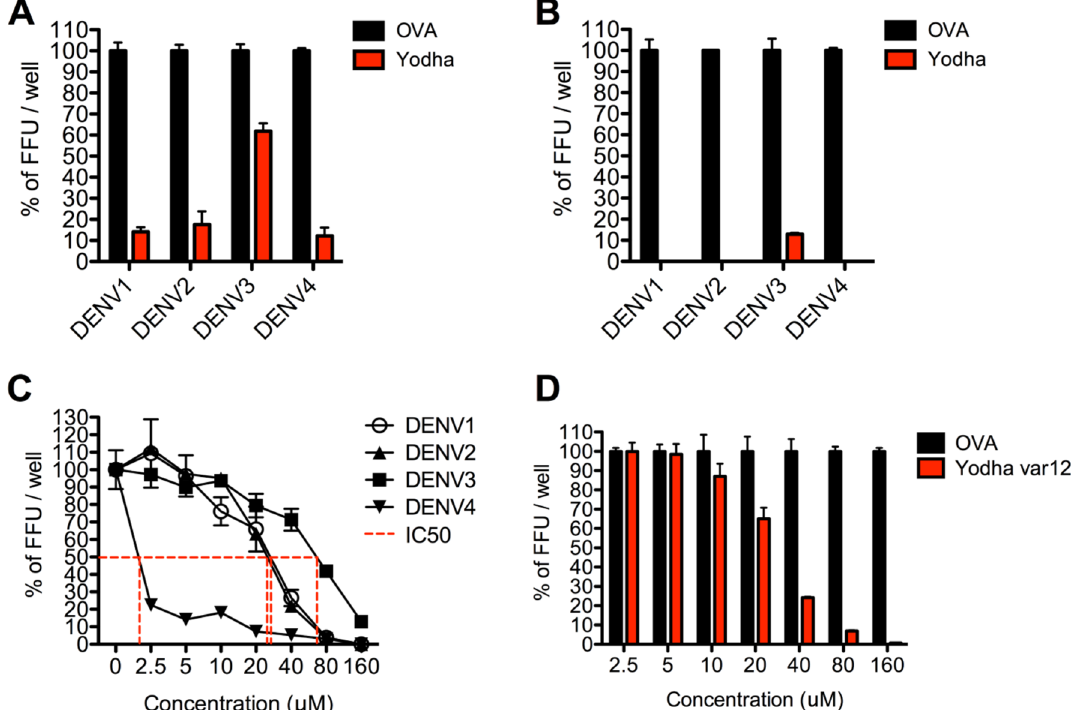
Figure 7. Yodha inhibits all four strains of DENV. Dengue virus strains 1, 2, 3 and 4 were treated with wither Yodha or control OVA peptide at ( A ) 50 µM ( B ) 160 µM concentration and the % of viral focus forming units were determined. ( C ) IC 50 measurement of Yodha in DENVs infection by FFA. ( D ) Dose escalation of truncated Yodha variant 12 against DENV3 infection shows that the truncated version is more efficient than the full length Yodha peptide. OVA peptide was used a negative